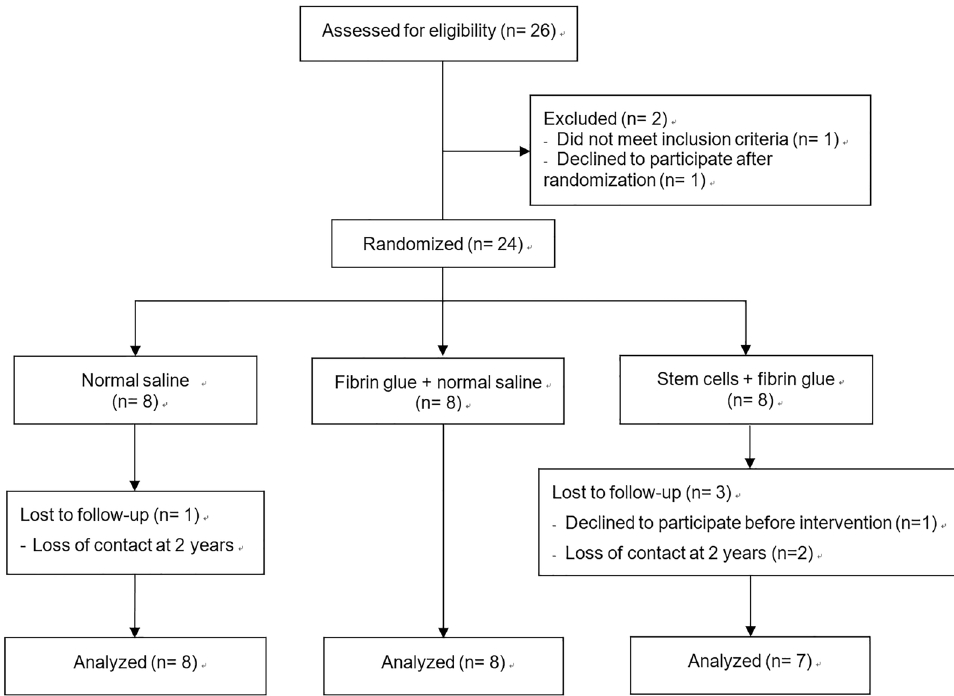
Figure 1. Flow diagram of the study population.